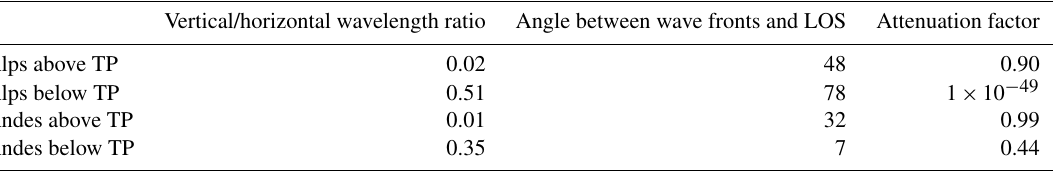
Table 1. Attenuation factor as a function of the ratio of GW vertical and horizontal wavelengths and the angle (on the horizontal plane) between the wave fronts and the LOS for the Alps and Andes case studies above and below the tropopause level (TP). Considerable (partial) attenuation below the tropopause in the Alps (Andes) region is expected. Line 1 in the table refers to the wave seen in ERA-Interim (Fig. 7), while lines 2 to 4 in this table refer to the WRF simulations.